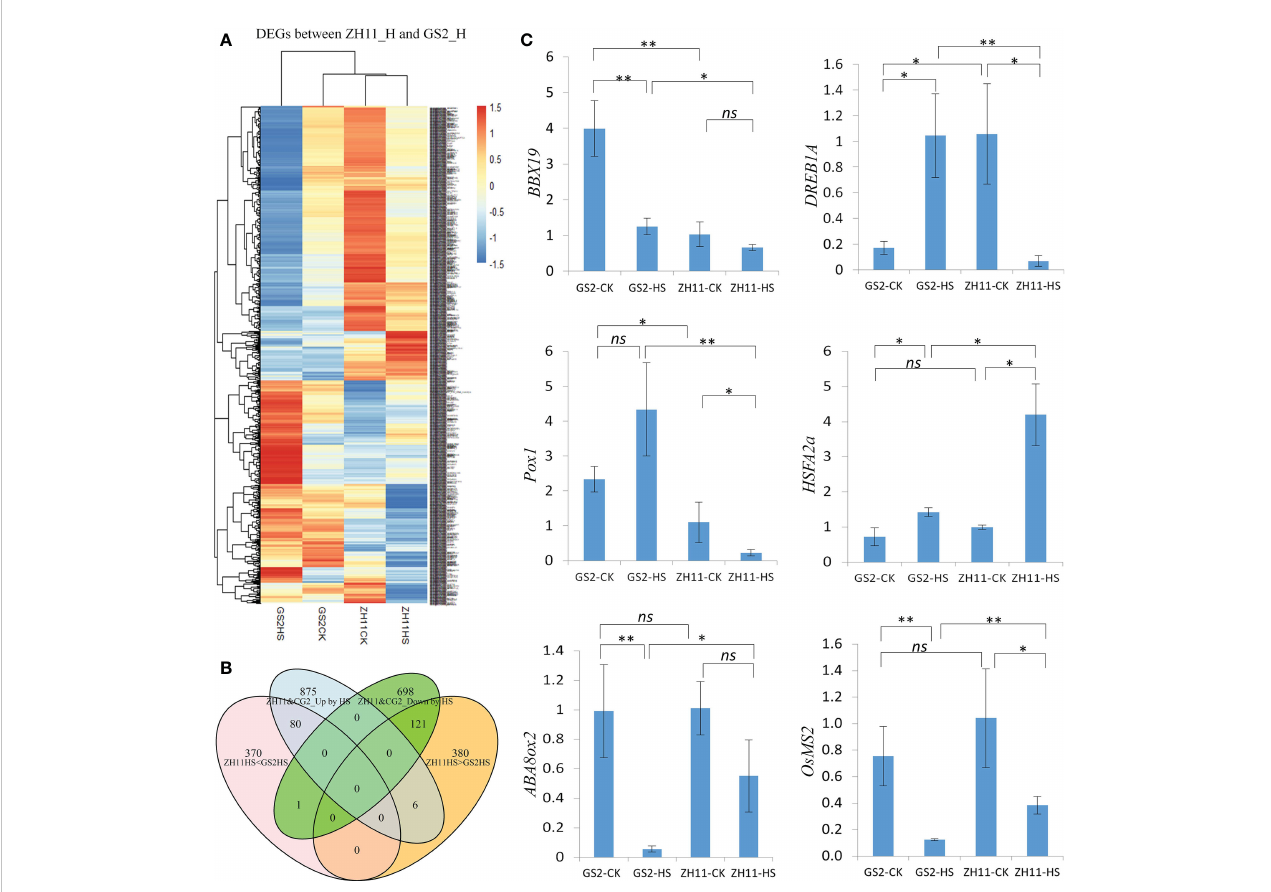
FIGURE 4 Expression patterns of differentially expressed genes (DEGs) between Zhonghua 11 (ZH11) and grain size on chromosome 2 (GS2) after heat stress (HS). (A) A heatmap showing expression patterns of DEGs in ZH11 and GS2 anthers after HS treatment. (B) Numbers of overlapping and speci fi c DEGs between four comparisons in our study, namely ZH11HS < GS2HS (DEGs with lower expression levels in ZH11 than in GS2 after HS), ZH11&GS2_Up by HS (DEGs up-regulated by HS treatment in both ZH11 and GS2), ZH11&GS2_Down by HS (DEGs down-regulated by HS treatment in both ZH11 and GS2), and ZH11HS > GS2HS (DEGs with higher expression levels in ZH11 than in GS2 after HS). (C) Reverse transcription-quantitative PCR (qRT-PCR) validation of RNA sequencing (RNA Seq) data with some of these genes: BBX19 , DREB1A , Pox1 , HSFA2a , ABA8ox2 , and OsMS2 . Signi fi cance level for t -test: * p < 0.05; ** p < 0.01. ns, non-signi fi